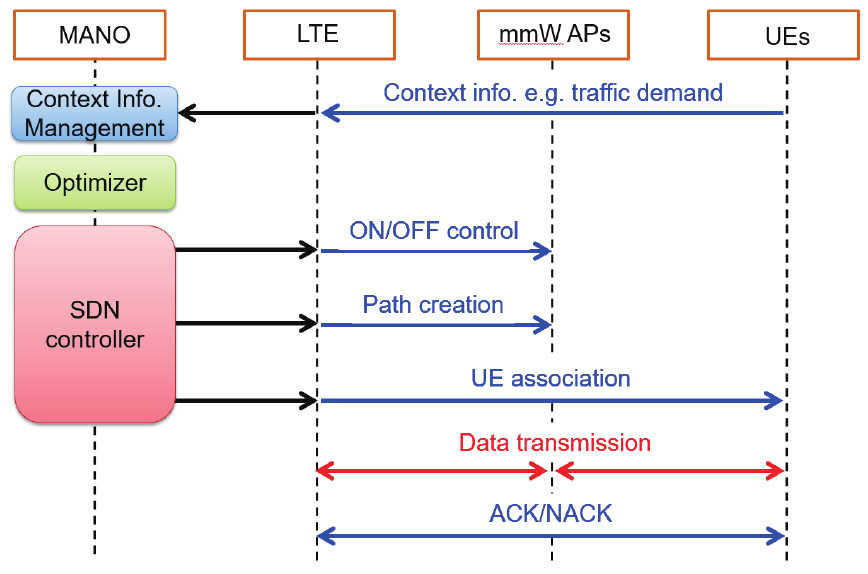
Figure 6. Functionalities of the controller (MANO) and signaling over out-of-band